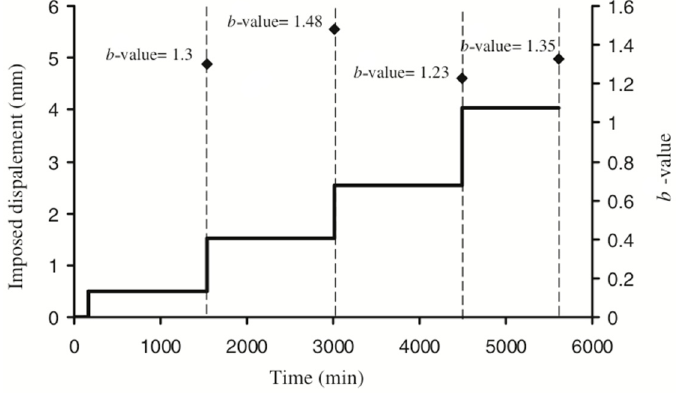
Figure 11. Evolution of the b ‐ value compared to pile’s incremental settlements.